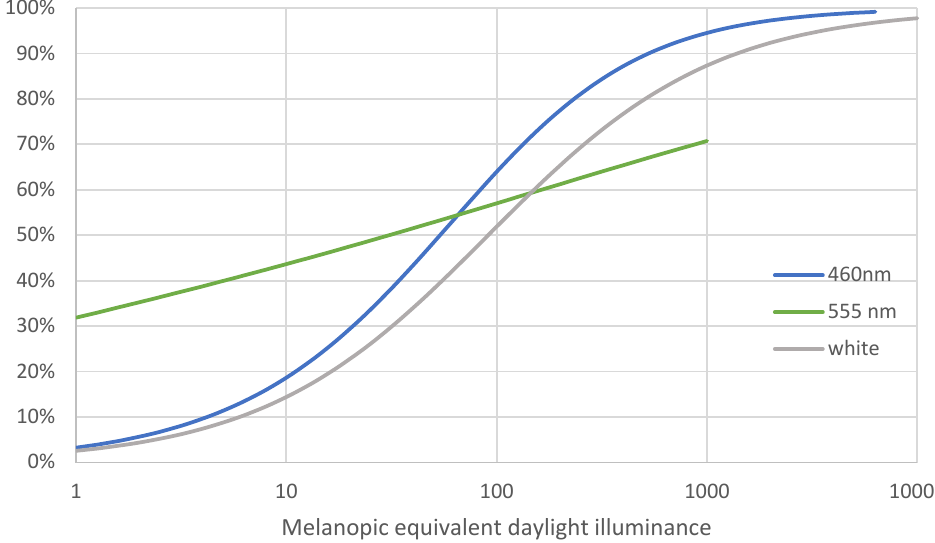
Figure A4. Normalized circadian phase-shift as a function of melanopic equivalent daylight illuminance with non-dilated pupils for a 6500 K fluorescent 6.5h nighttime illumination and for 460 nm and 555 nm illumination.